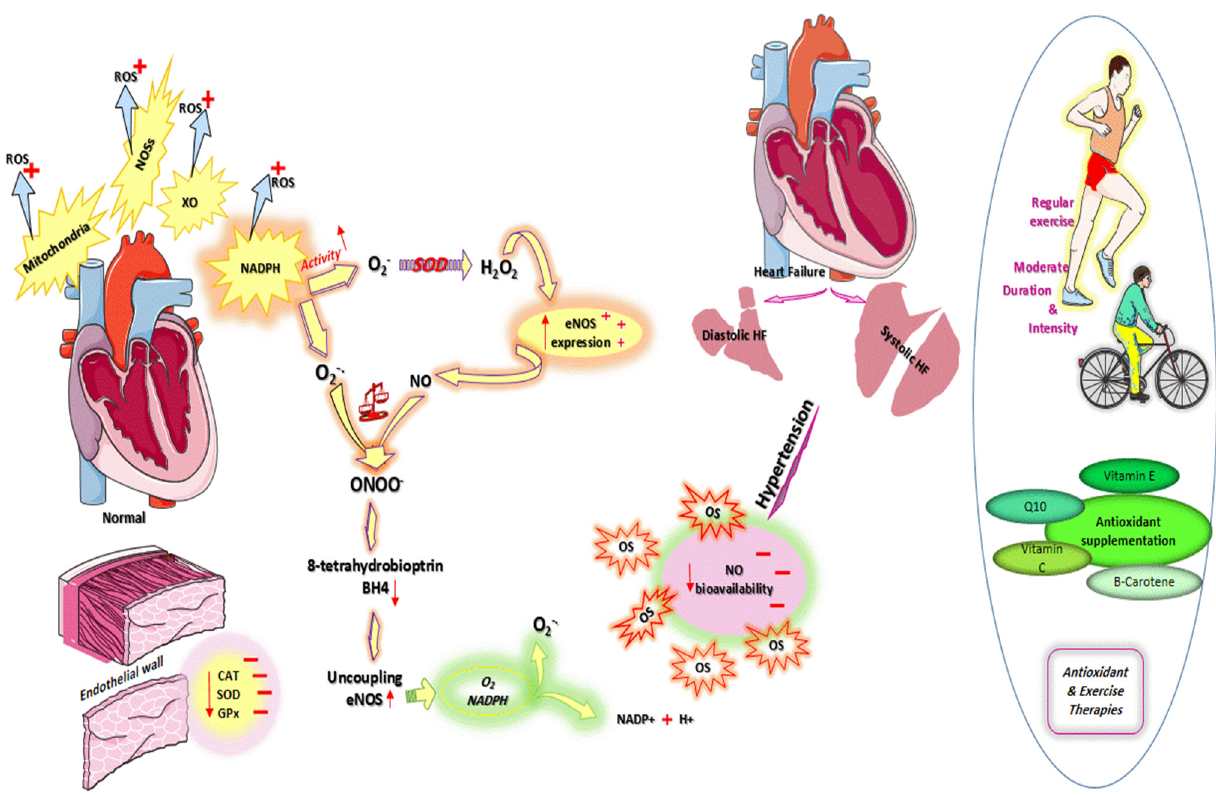
Figure 1. Cardiovascular oxidative stress. OS: Abbreviations: oxidative stress; ROS: reactive oxygen species; HF: heart failure; NOSs: nitric oxide synthases; XO: xanthine oxidase; NADPH: nicotinamide adenine dinucleotide phosphate hydrogen; SOD: superoxide dismutase; GPx: glutathione peroxidase; CAT: catalase; Enos:endothelial nitric oxide synthase; BH4: 8-tetrahydrobiopterin; O 2 − : superoxide anion; ONOO − : Peroxynitrite.